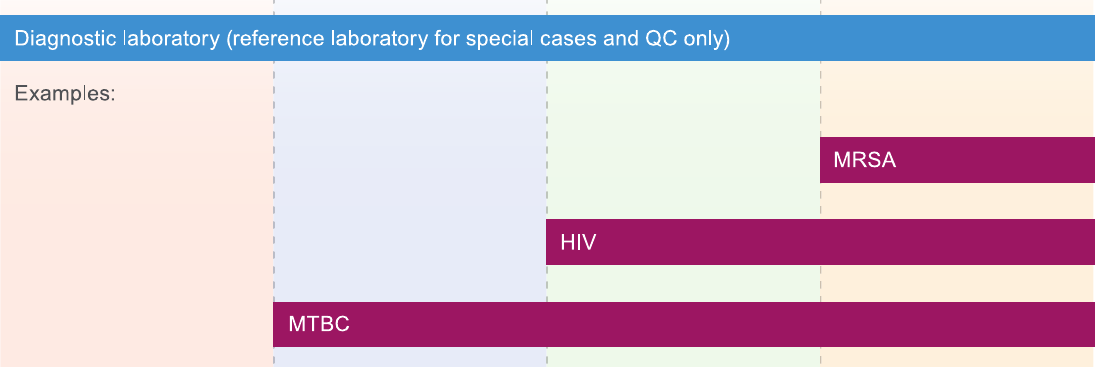
Figure 1. Potential impact of whole genome sequencing in diagnostic and public health microbiology. Clinical samples processed by diagnostic microbiology laboratories commonly pass through up to four stages, characterised by a stepwise decrease in the number of samples analysed at each successive stage and an inverse association with turn-around time (TAT), labour, and costs (shown in dark blue). Detection, identification, and susceptibility testing in virology are achieved using serological or molecular methods, whereas bacteriology generally relies on phenotypic methods. Epidemiological typing is only done for a handful of organisms using molecular and sometimes phenotypic methods. The most compelling immediate applications for WGS are molecular epidemiology for the purposes of surveillance and outbreak investigation (e.g. for MRSA) and drug susceptibility testing for organisms that are either slow growers or difficult to culture (e.g. MTBC and HIV). This is likely to lead to more samples being typed than is currently the case (depicted in purple), all while drastically reducing turnaround times, provided that WGS is performed in a regional or local laboratory rather than a reference centre. Assuming that this information enables cost-effective clinical interventions, the